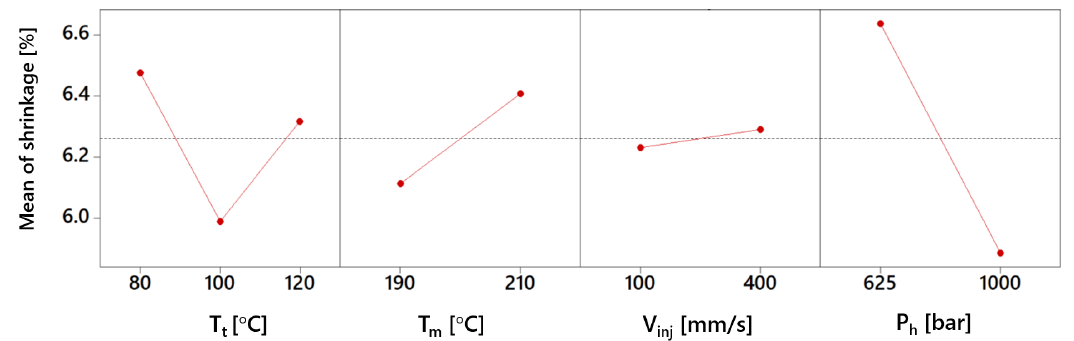
Figure 8. Main effect plots for shrinkage (the dashed lines show the total averages).